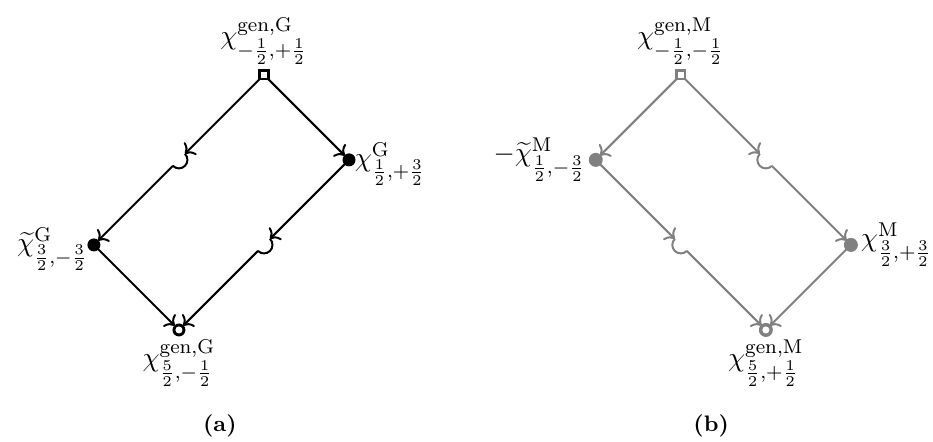
Figure 6. Goldstone (a) and memory (b) diamonds for the leading soft gravitino theorem.